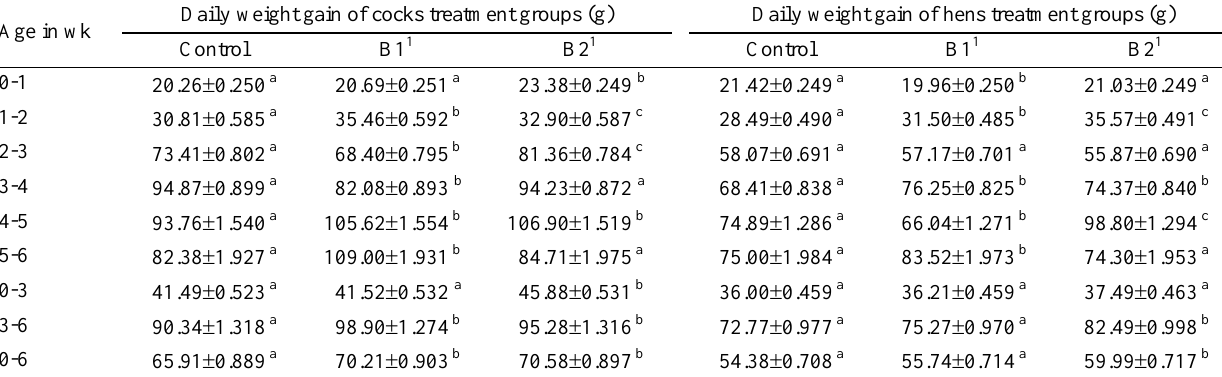
Table 2. Weekly body weight means of broiler fed on ration containing different concentration of probiotics Daily weight gain of cocks treatment groups (g) Daily weight gain of hens treatment groups (g) Age in wk